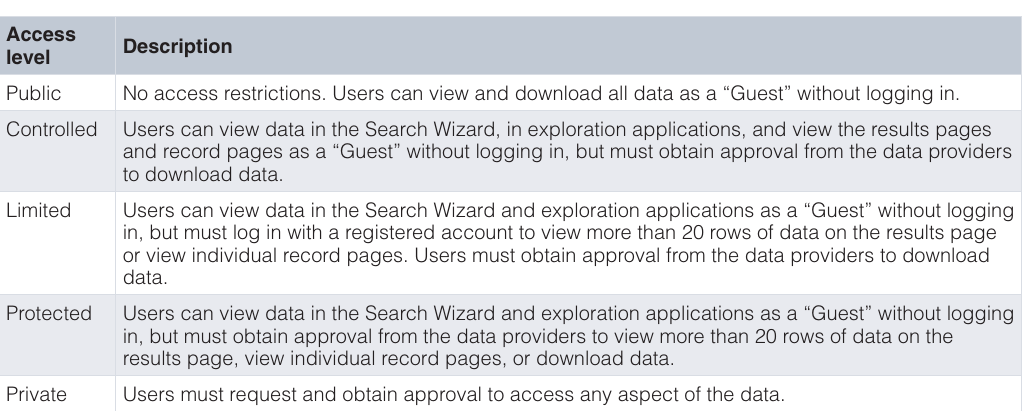
Table 3. Data access restriction